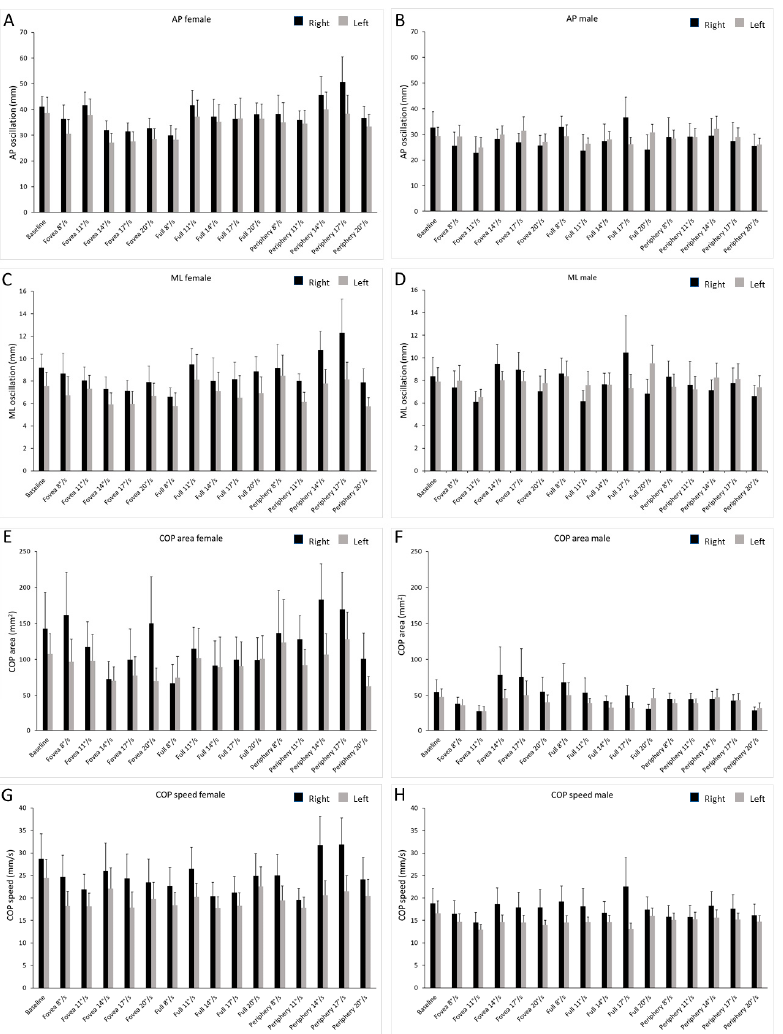
Figure 3. Bar graph of COP parameters in the left and right limb of male and female subjects. Values are shown during optic flow stimuli at different speeds and baseline. The black bars represent the right limb, and the gray bars represent the left limb. Data are shown as mean ± SE. ( A ) AP oscillations in females. ( B ) AP oscillations in males. ( C ) ML oscillations in females. ( D ) ML oscillations in males. ( E ) COP area in females. ( F ) COP area in males. ( G ) COP speed in females. ( H ) COP speed in males.